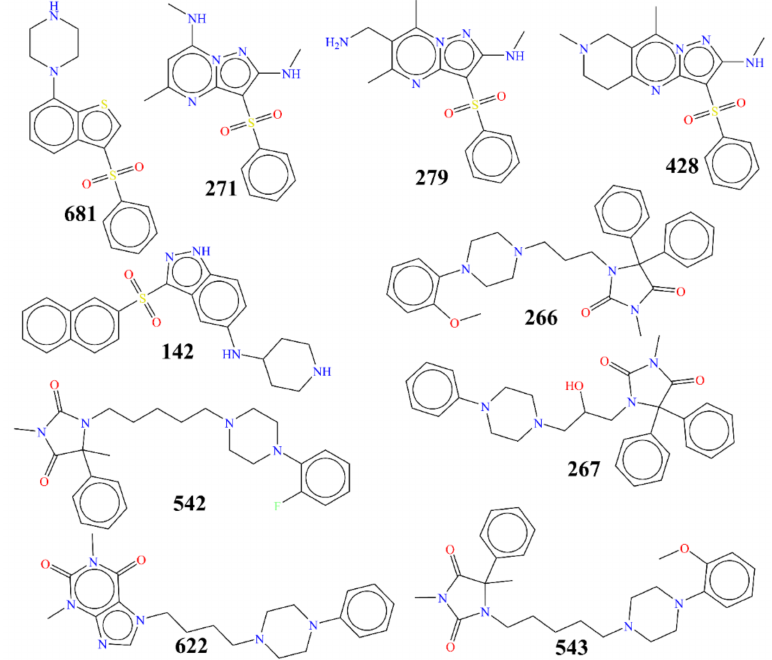
Figure 11. Representative examples from the selected dataset (five most active and five least active molecules) of 5-HT6